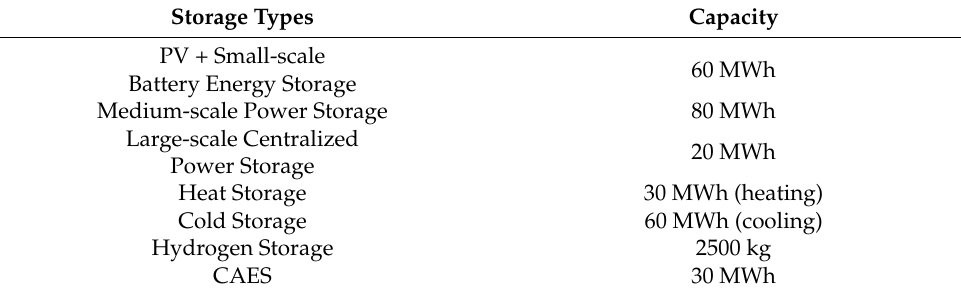
Table 13. The capacities of different storage